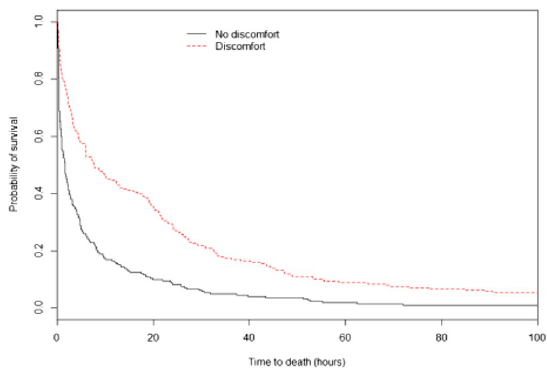
Fig. 1 Survival probability in patients with and without